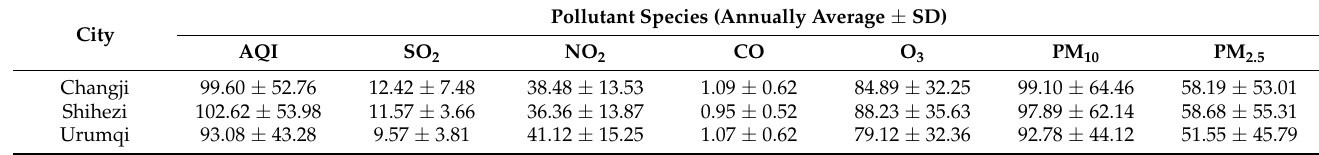
Table 2. AQI and concentration levels of major air pollutants in Wu-Chang-Shi urban, 2017–2021. ( µ g m − 3